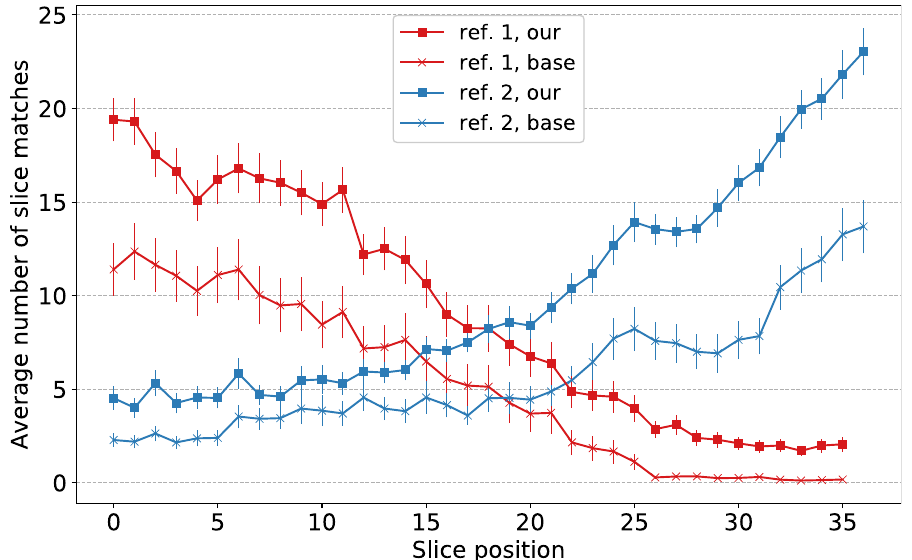
Fig 10. Correlation of slice position and number of slice matches. Red graphs represent the average number of slice matches for the first reference sequence (averaged over all subjects). Blue graphs correspond likewise to the second reference sequence. Graphs with squares represent our method; graphs with crosses represent the baseline method. Error bars represent standard deviation and are scaled by 0.1 for better readability.